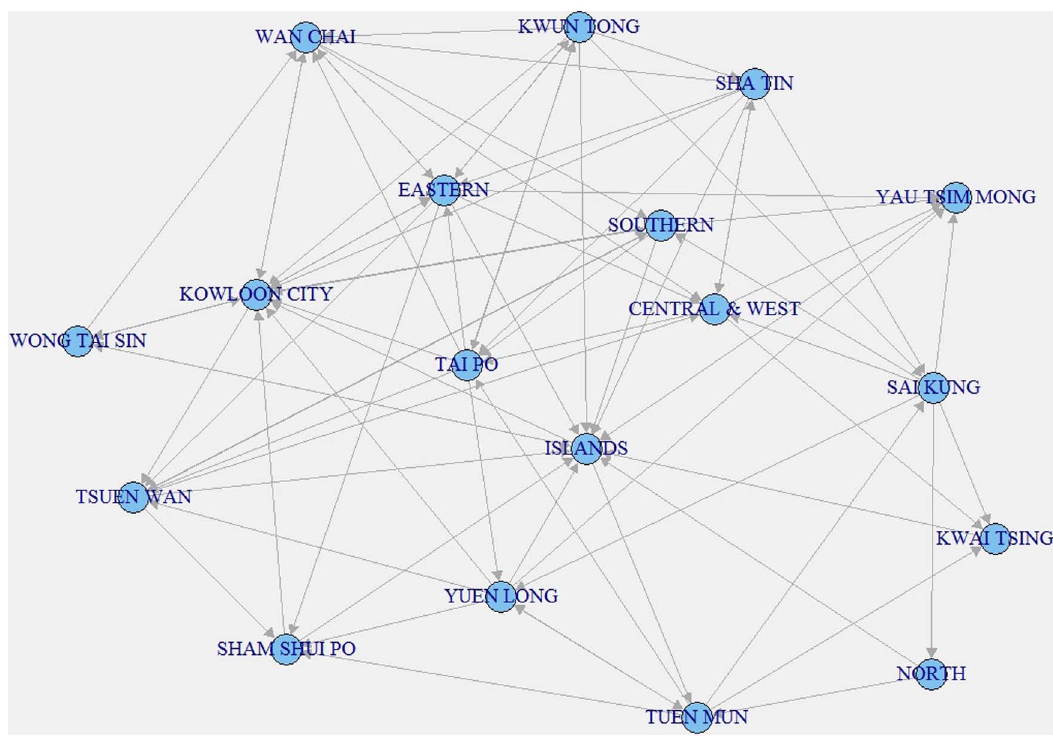
Figure 4. Computed spreading network of 2009 H1N1 in Hong Kong.